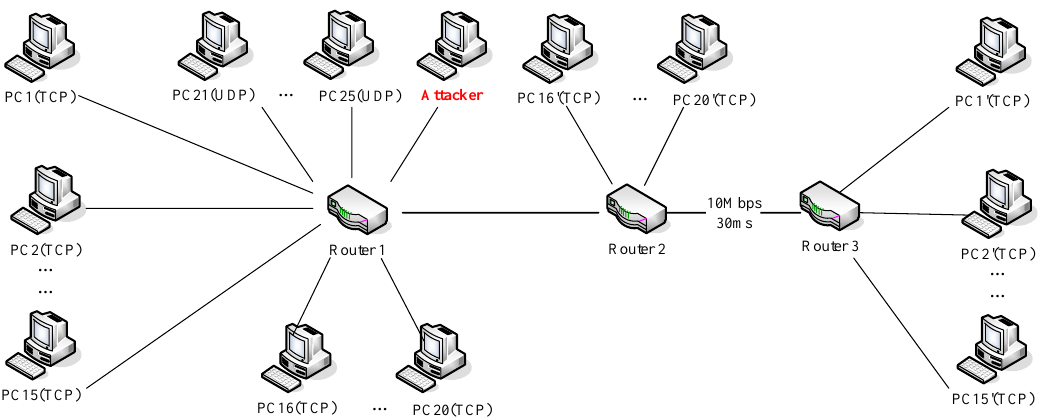
Figure 10. Topology of Network Simulator 2 (NS2) simulation experiment